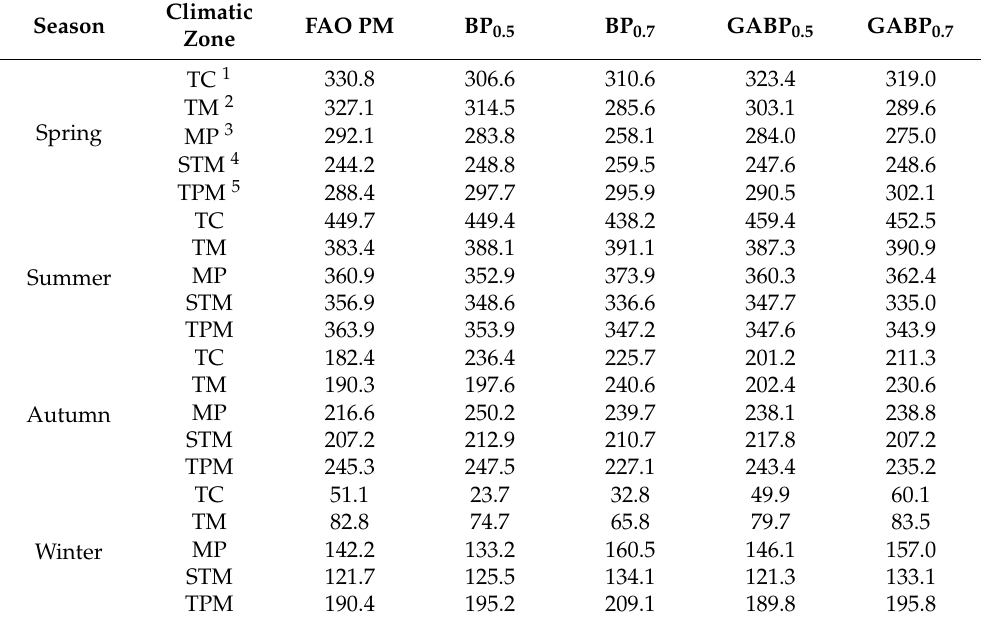
TPM Note: 1 TC, temperate continental zone; 2 TM, temperate monsoon zone; 3 MP, mountain plateau zone; 4 STM, subtropical monsoon zone; 5 TPM, tropical monsoon